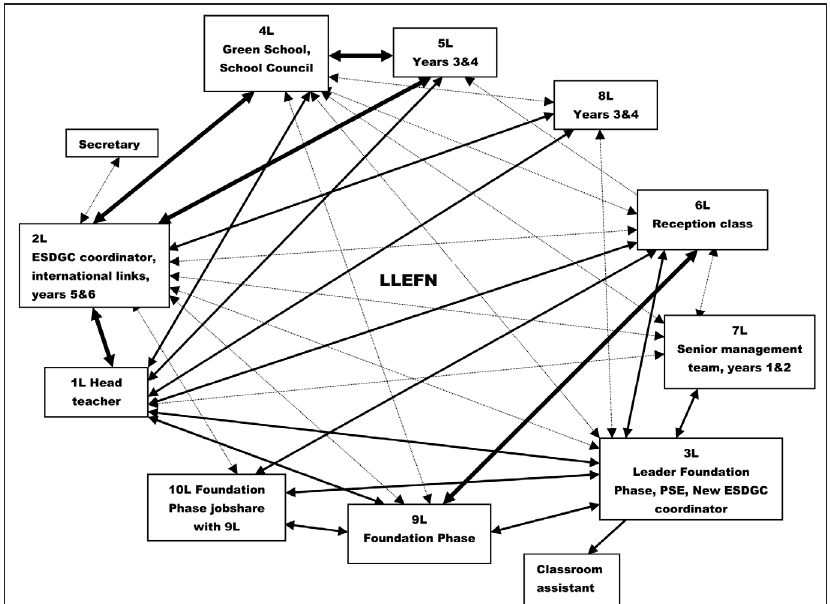
Figure 3b: Llefn teachers’ networks in school